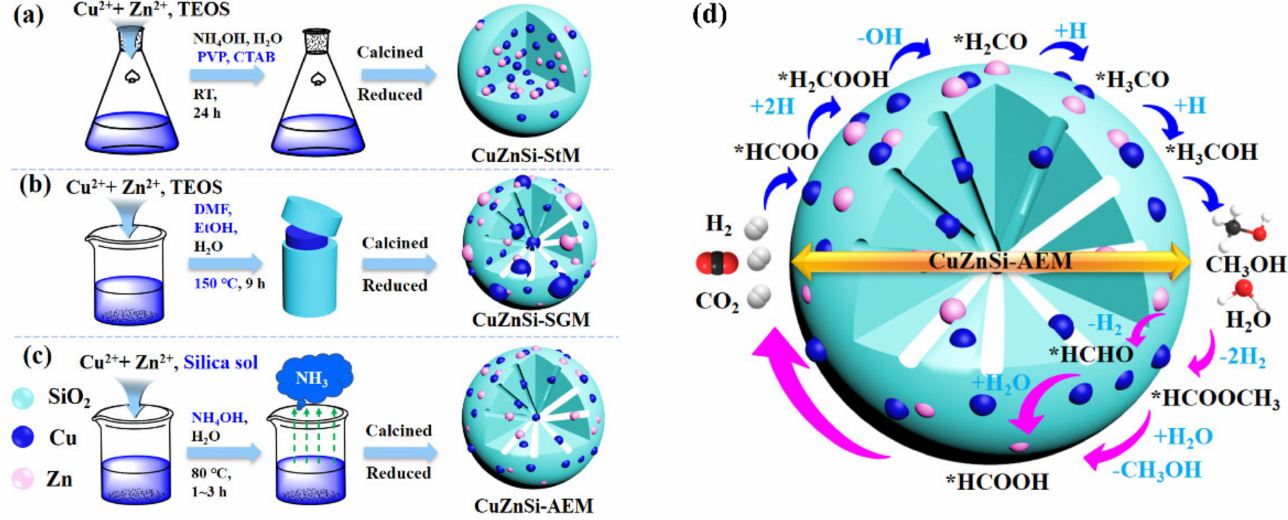
Figure 2. A series of CuZnSi catalysts were reported for CO 2 hydrogenation and methanol reforming reaction: ( a – c ) Schematic illustration of the preparation of three CuZnSi catalysts by different methods and ( d ) the mechanism of CuZnSi-AEM catalyst used for methanol synthesis and methanol reforming. Reproduced with permission [81]. Copyright Wiley-VCH,